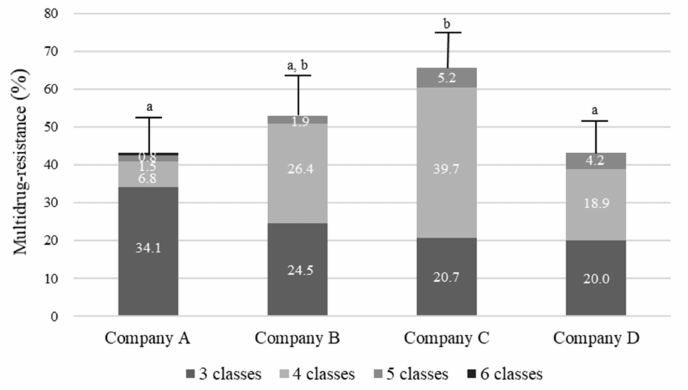
Figure 2. Distribution of multidrug resistant Enterococcus faecalis and Enterococcus faecium in bulk tank milk from four dairy companies. Values not sharing a common subscript letter (a,b) are statistically different ( p <